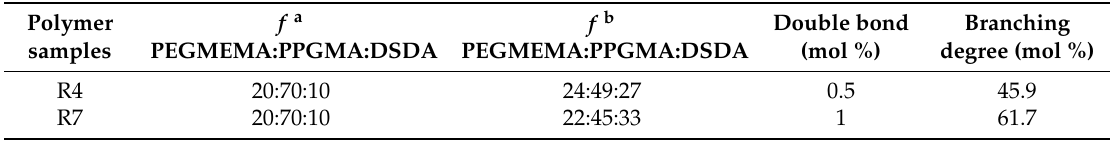
Figure 3. 1 H NMR of PEGMEMA–PPGMA–DSDA copolymer (R4, entry 4 in Table 1) prepared via RAFT polymerisation. Note: the spectrum shows clearly the double bonds within the structure and the copolymer composition ( m , n , r , p ) can be calculated from the integral data. Table 2. Compositions of PEGMEMA–PPGMA–DSDA copolymers.